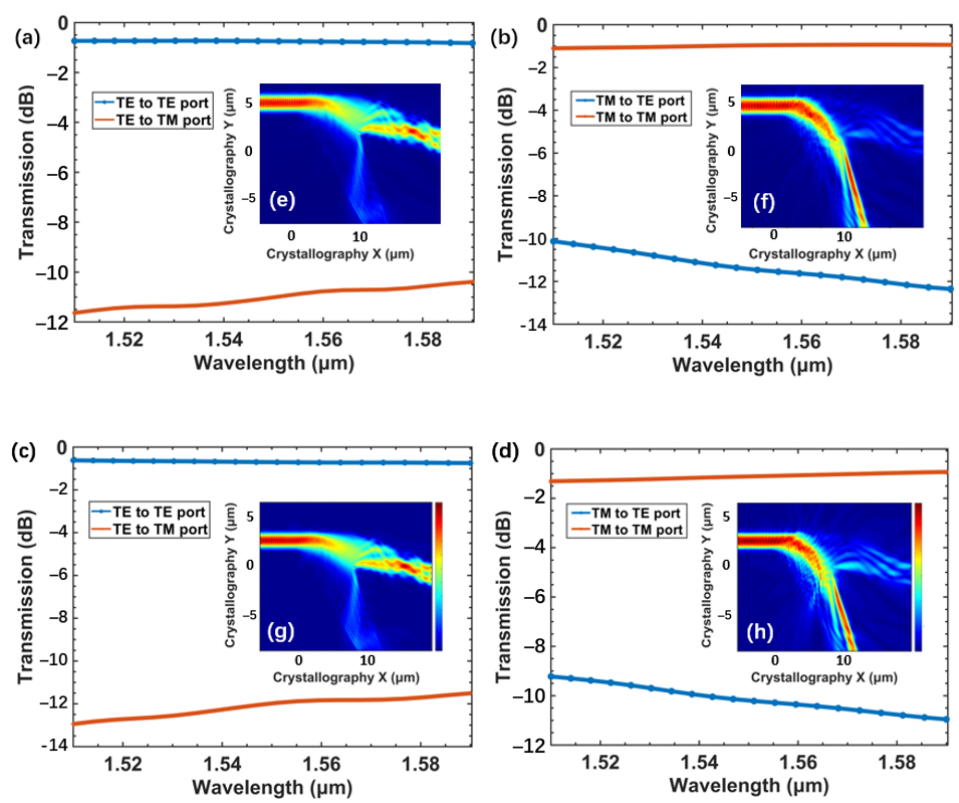
Figure 6. ( a ) Device performance under irregular etching conditions for TE mode and ( b ) TM mode. ( c ) Device performance when the metasurface layer suffers a 1 μm deviation for TE mode and ( d ) TM mode.